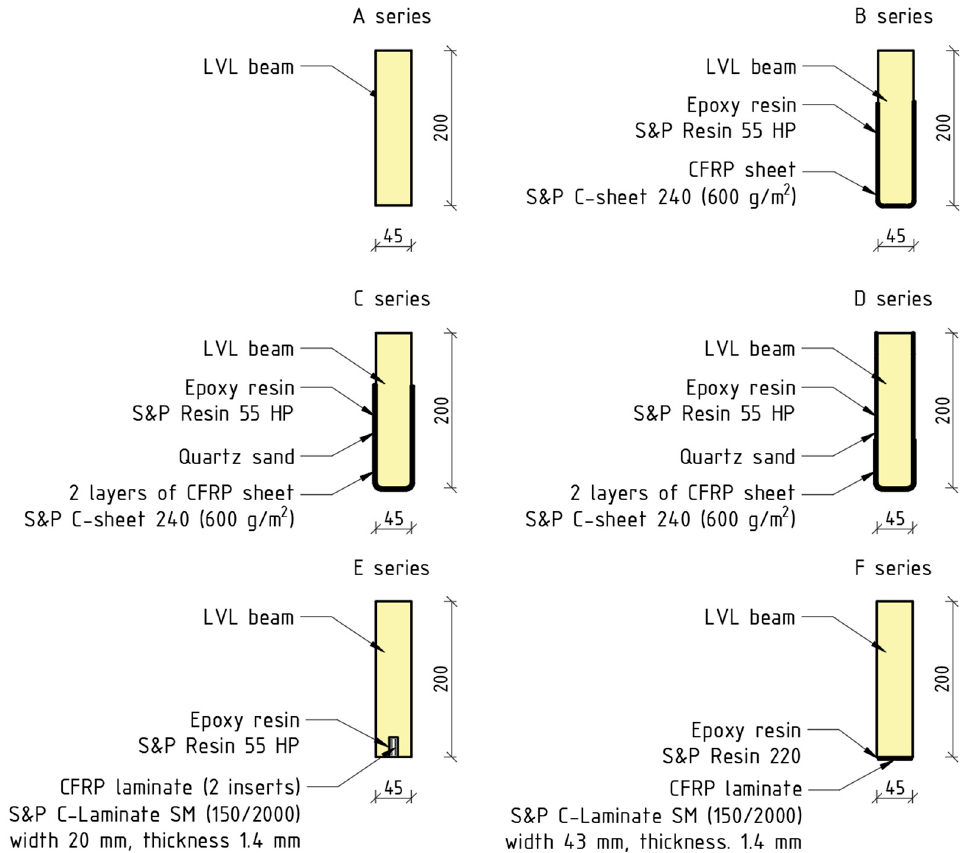
Figure 6. Strengthening configurations: A—unstrengthened beams; B—strengthened with one layer of CFRP sheet; C—beams strengthened with two layers of CFRP sheet bonded one on another; D—beams strengthened with two layers of CFRP sheet covering entire side surface; E—beams strengthened with two CFRP laminates bonded into predrilled grooves; F—beams strengthened with CFRP laminated bonded to bottom surface.